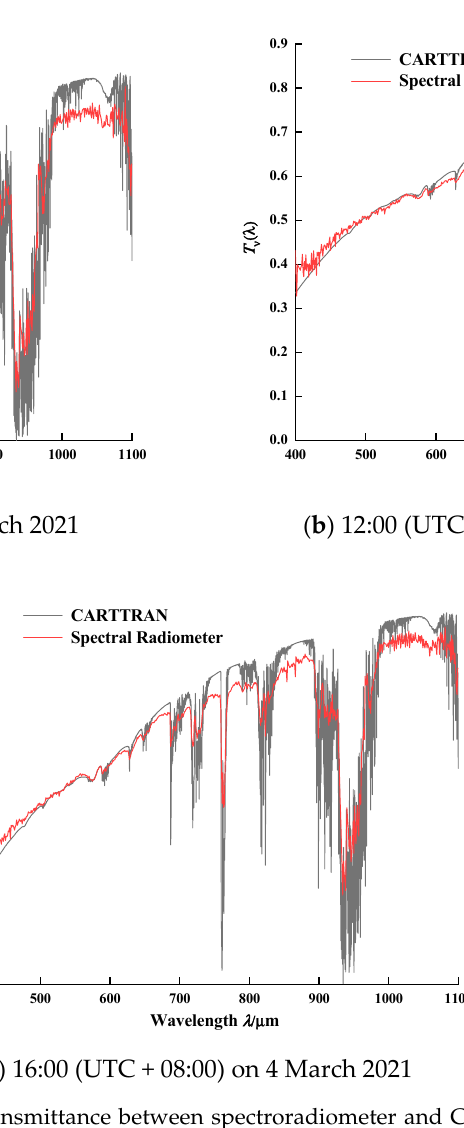
Figure 12. The continuous spectrum transmittance between spectroradiometer and CART in the morning, noon, and afternoon on 4 March 2021. Note the agreement of these observations between the two methods.